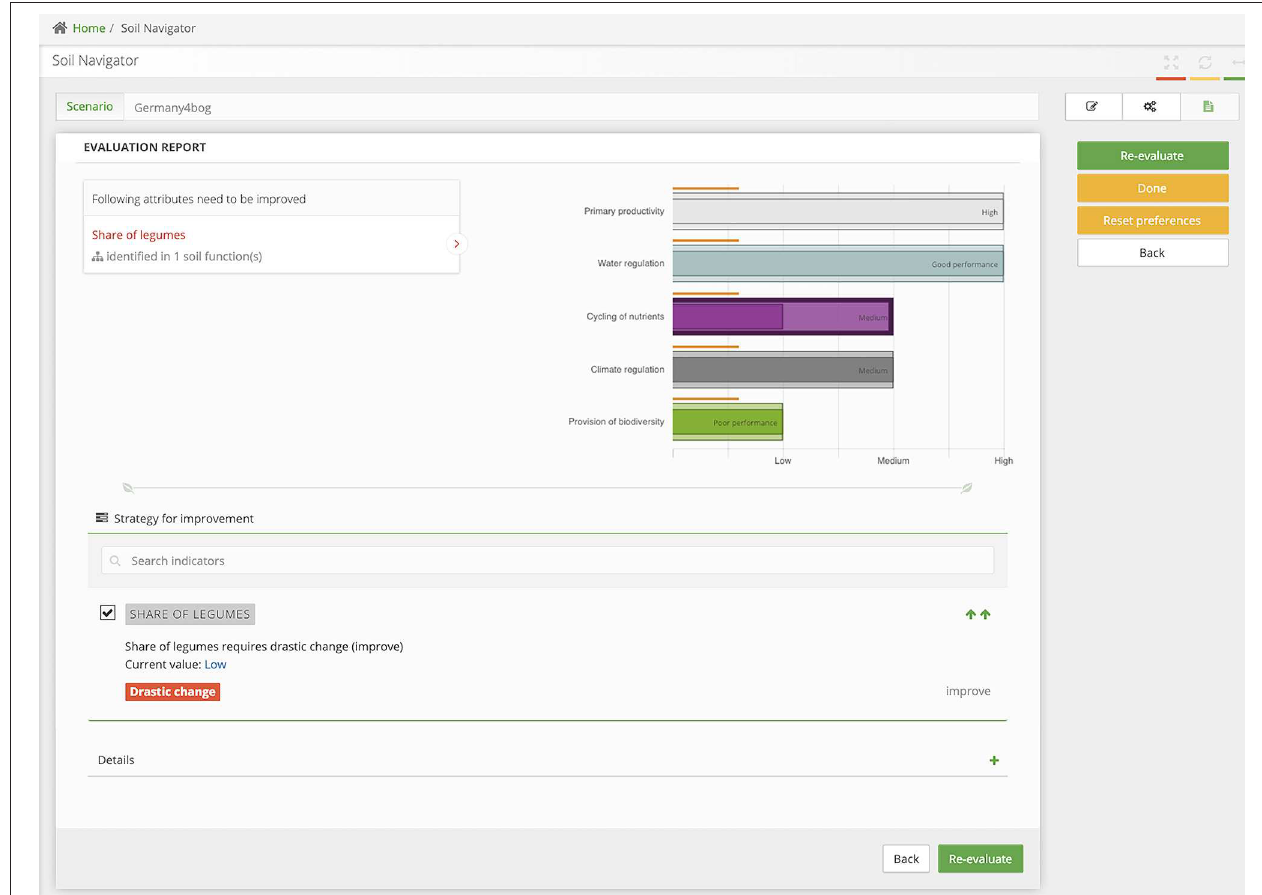
FIGURE 6 | Proposed suggestions for improvement of the performance of soil